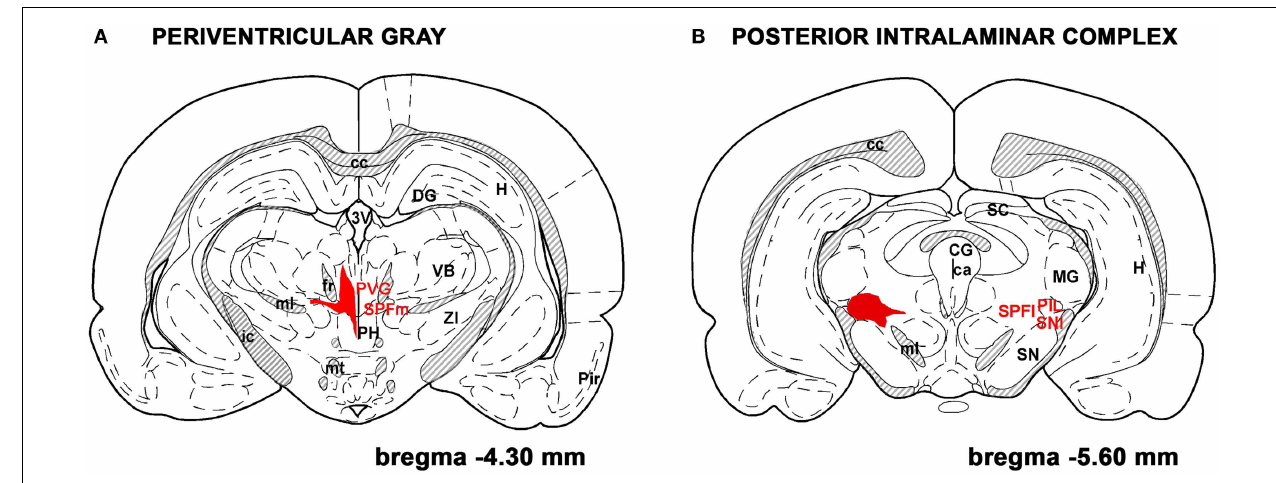
FIGURE 2 |TIP39 neurons in the subparafascicular area. The subparafascicular area is a mediolaterally and to some degree rostrocaudally elongated region. MostTIP39 cells are located in its mediorostral portion, the periventricular gray of the thalamus (A) and in its caudolateral part, the posterior intralaminar complex of the thalamus (B) .The area whereTIP39 neurons are distributed is shown in red. A fewTIP39 neurons are scattered between these two regions below the fasciculus retroflexus and above the medial lemniscus. Additional abbreviations: ca, cerebral aqueduct; cc,